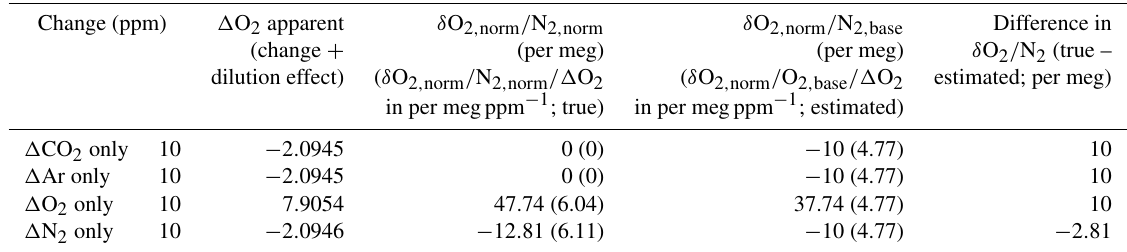
Table A2. Mole fraction to delta conversion for air-like compositions according to different scenarios. Change